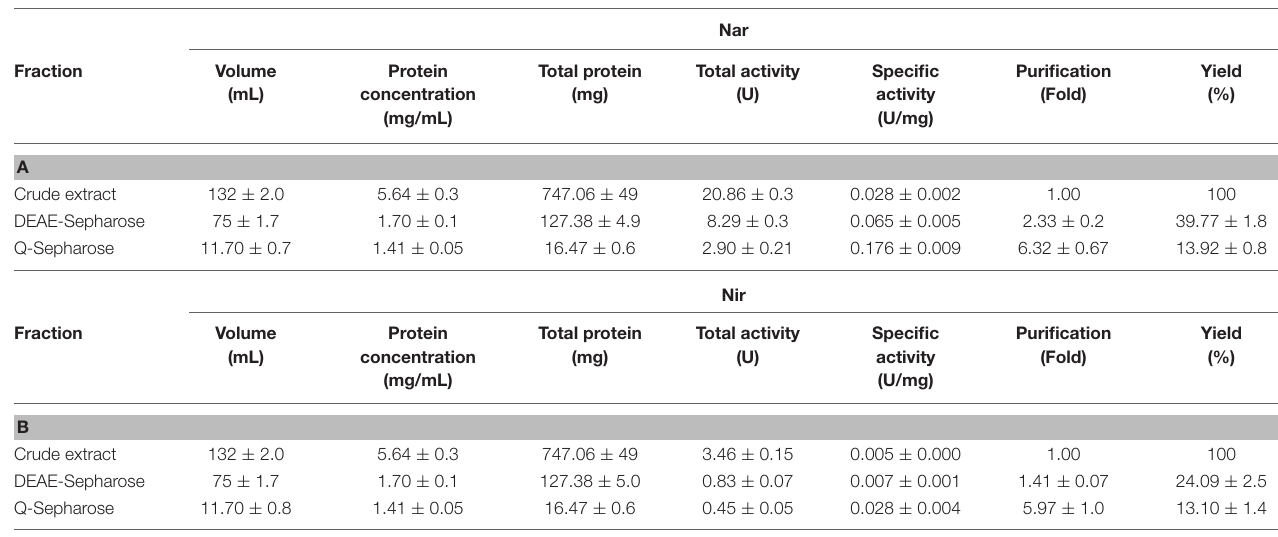
TABLE 3 | Purification parameters of Nar (A) and Nir (B) during the enrichment of